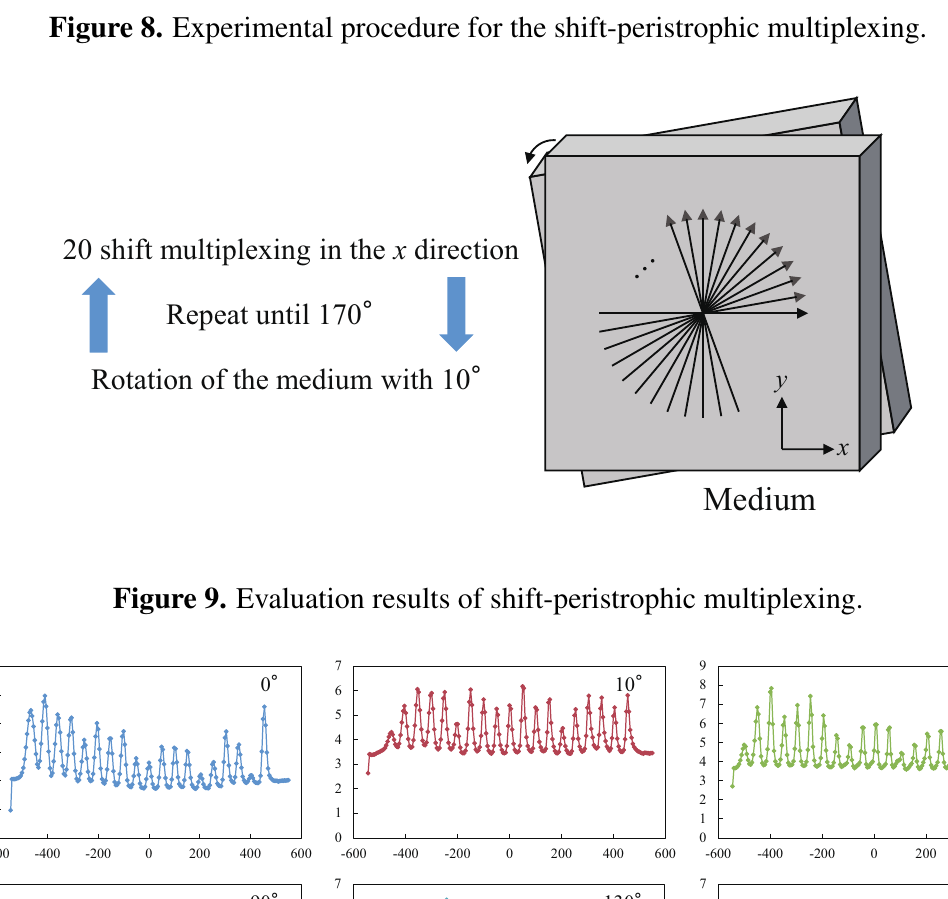
Figure 8. Experimental procedure for the shift-peristrophic multiplexing.